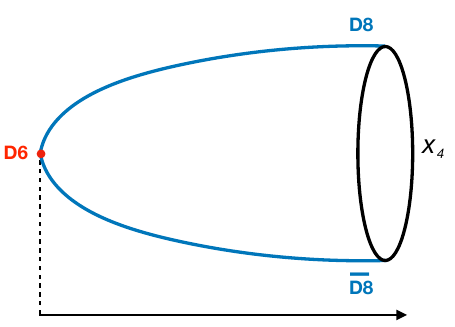
Figure 2 . Flavors and domain walls in the Witten-Sakai-Sugimoto model. The (cid:13)avor D8/D8- branes are placed at (cid:12)xed antipodal point on the S x direction. The D6-branes sit at the tip of the cigar